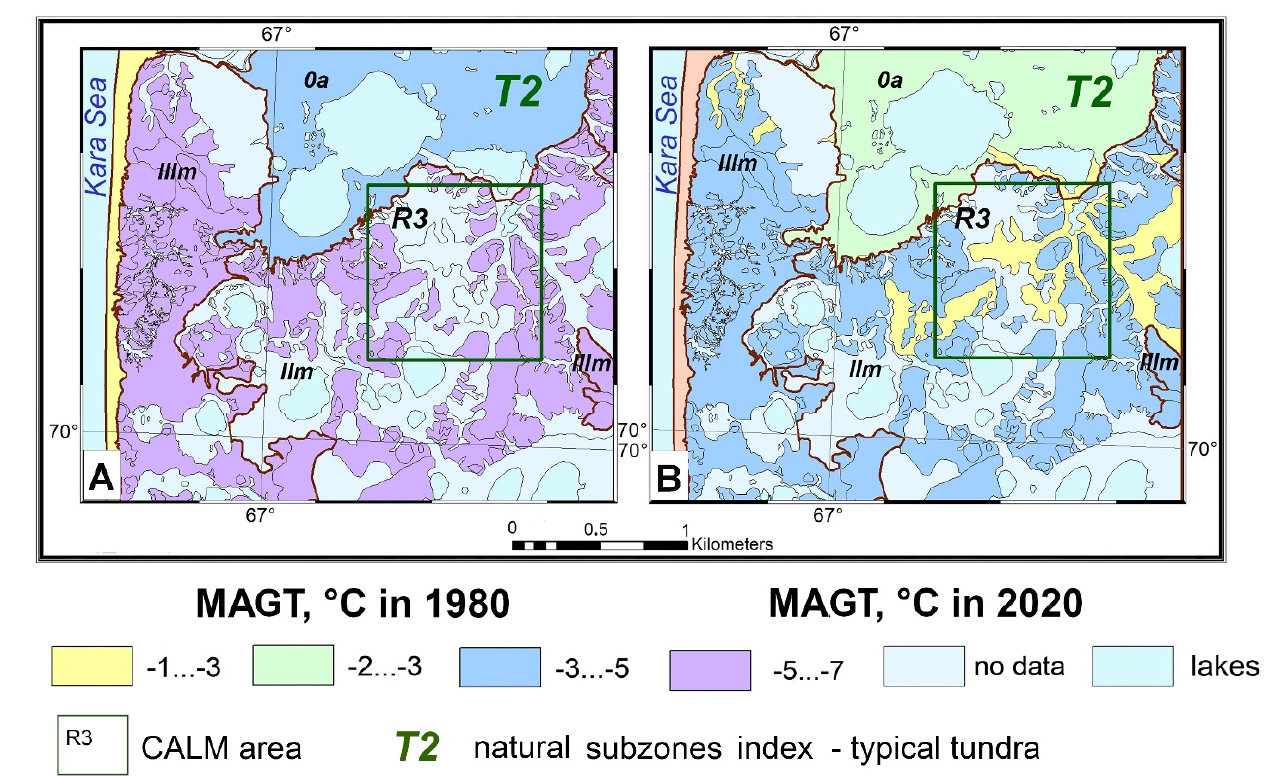
Figure 7. Changes in the mean annual ground temperature for two time intervals, Western Yamal, Marre-Sale station, typical tundra: ( A ) in the 1980s and ( B ) the modern period, 2020.